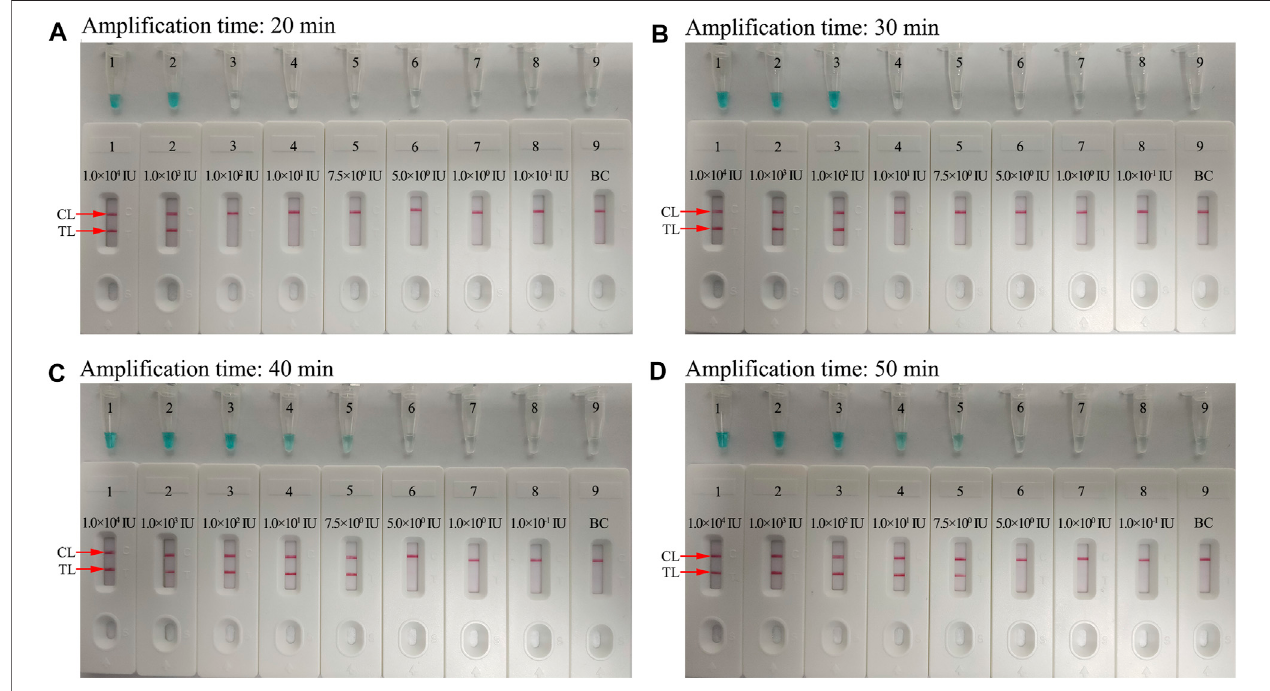
FIGURE 7 | Optimization of the ampli fi cation time for HBV-LAMP-LFB detection. Different ampli fi cation time intervals, (A) 20 min, (B) 30 min, (C) 40 min, and (D) 50 min,weretestedat65 ° C.Tubes1 – 7(Biosensors1 – 7)representHBVgenomicDNAlevelsof1 × 10 4 IU,1 × 10 3 IU,1 × 10 2 IU,10 IU,7.5 IU,5 IU,1 IU,and0.1 IUper reaction and BC (DW), respectively. The best sensitivity was observed when the ampli fi cation lasted for 40 min.